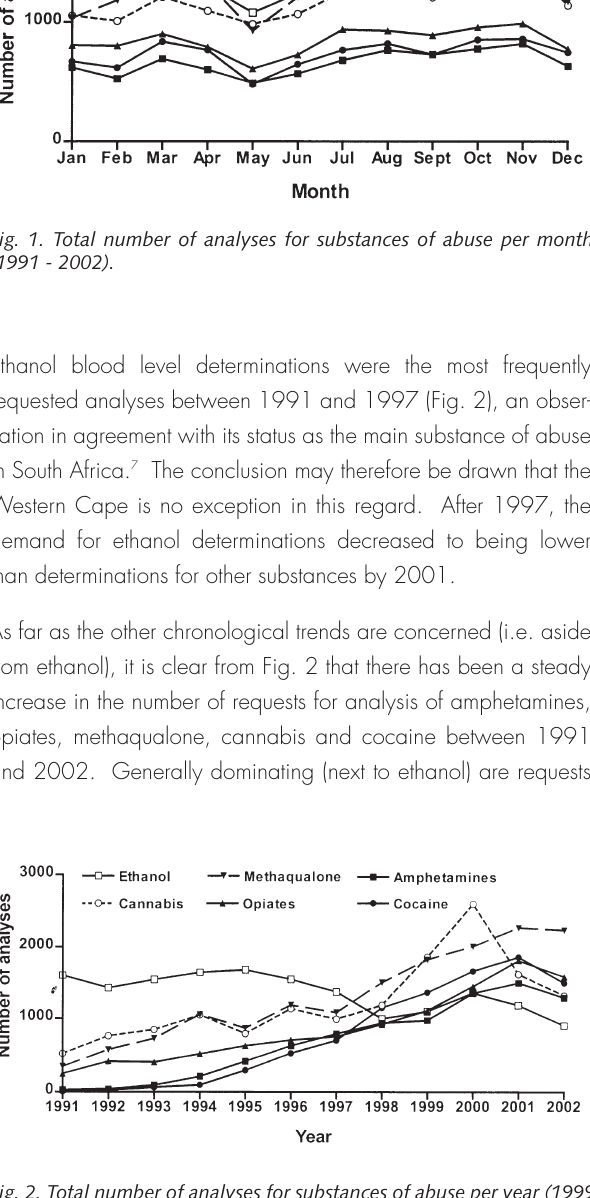
Fig. 2. Total number of analyses for substances of abuse per year (1999 -